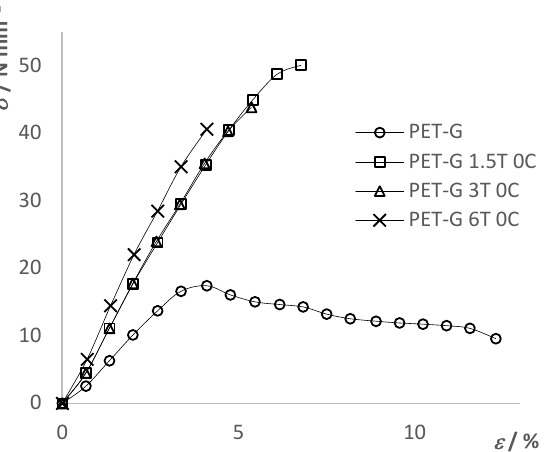
Figure 8. Tensile test results of PET-G and PET-G/TiO 2 composites.